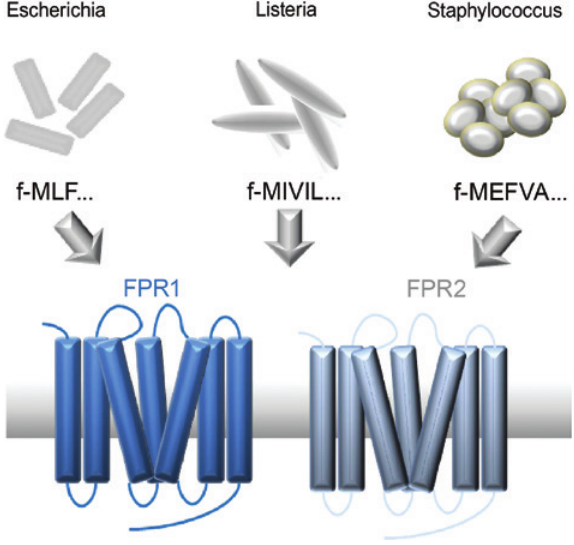
Figure 2: FPRs recognize formylated peptides from different